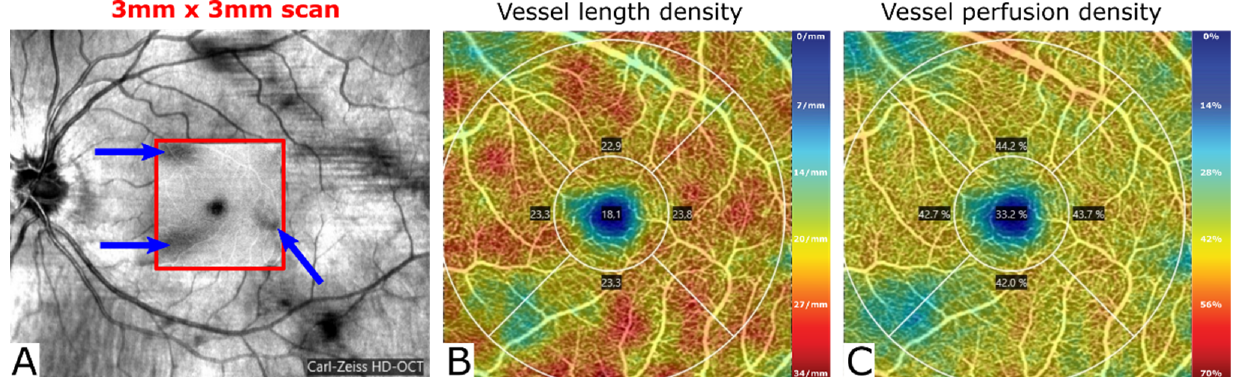
Figure 2. Example of color-coded images of vessel length density and vessel perfusion density of a 3 × 3 mm OCT-A scan of a left eye performed with Zeiss Cirrus 6000 (100.000 scans per second). ( A ) Corresponding fundus image with the location of 3 × 3 mm scan in the center of the macula (red outlined square). Note that the subject has vitreous floaters (blue arrows) inside the scan area that negatively influence the OCT-A signal quality and analysis in the areas below the floaters (shadow artifact). ( B ) Color-coded image of the vessel length density [mm − 1 ] (Zeiss definition: total length of vessels per unit area; large and small vessels have equal influence on the result). Dark blue areas as the FAZ are completely avascular, red areas have a high vessel length density. Due to low signal quality in the areas below the vitreous floaters, vessel length density is falsely reduced in these areas due to the shadow artifact. Numbers in the sectors of the superimposed EDTRS-grid show the mean sector vessel length density. ( C ) Color-coded image of the vessel perfusion density [%] (Zeiss definition: total vessel area per unit area; large vessels have greater influence than small vessels). Dark blue areas, such as the FAZ, are avascular, and yellow and red areas have higher vessel perfusion density. Due to low signal quality in the areas below the vitreous floaters, vessel perfusion density is falsely reduced in these areas due to the shadow artifact. Numbers in the sectors of the superimposed EDTRS-grid show the mean sector vessel perfusion density. FAZ = foveal avascular zone.